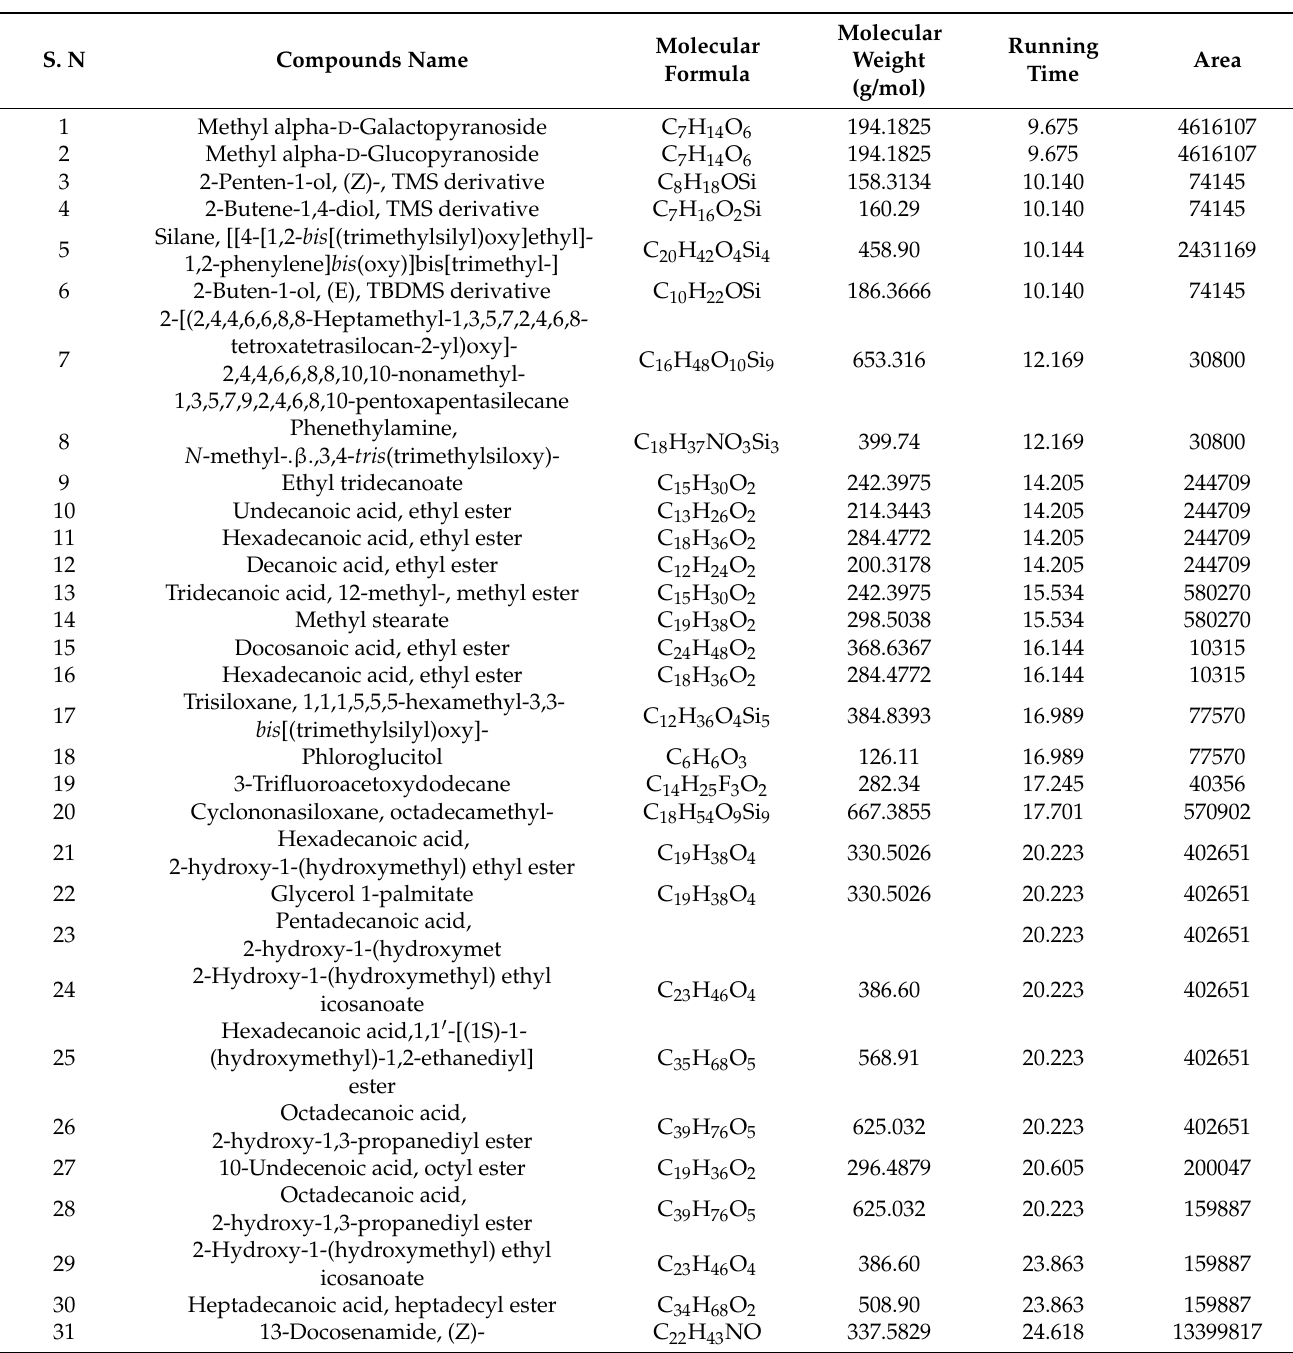
Table 1. Compounds identified in the ME X LS by